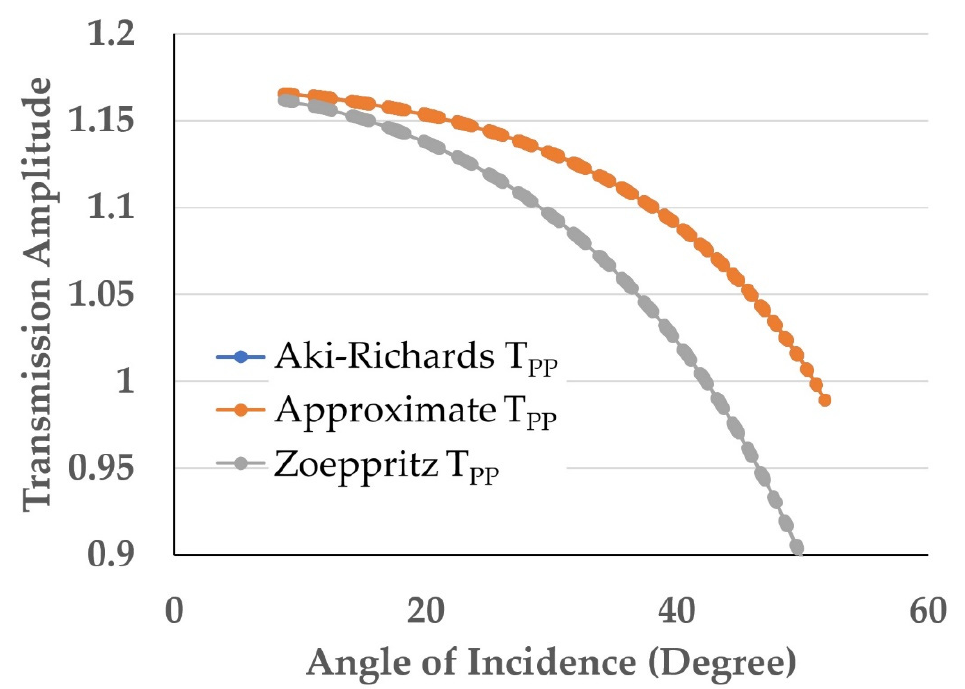
Figure 5. Fitting angle–amplitude (T PP ) data of CTP 63 in the gas channel. Table 5. Values of fitting parameters for CTP 63 in the gas channel.